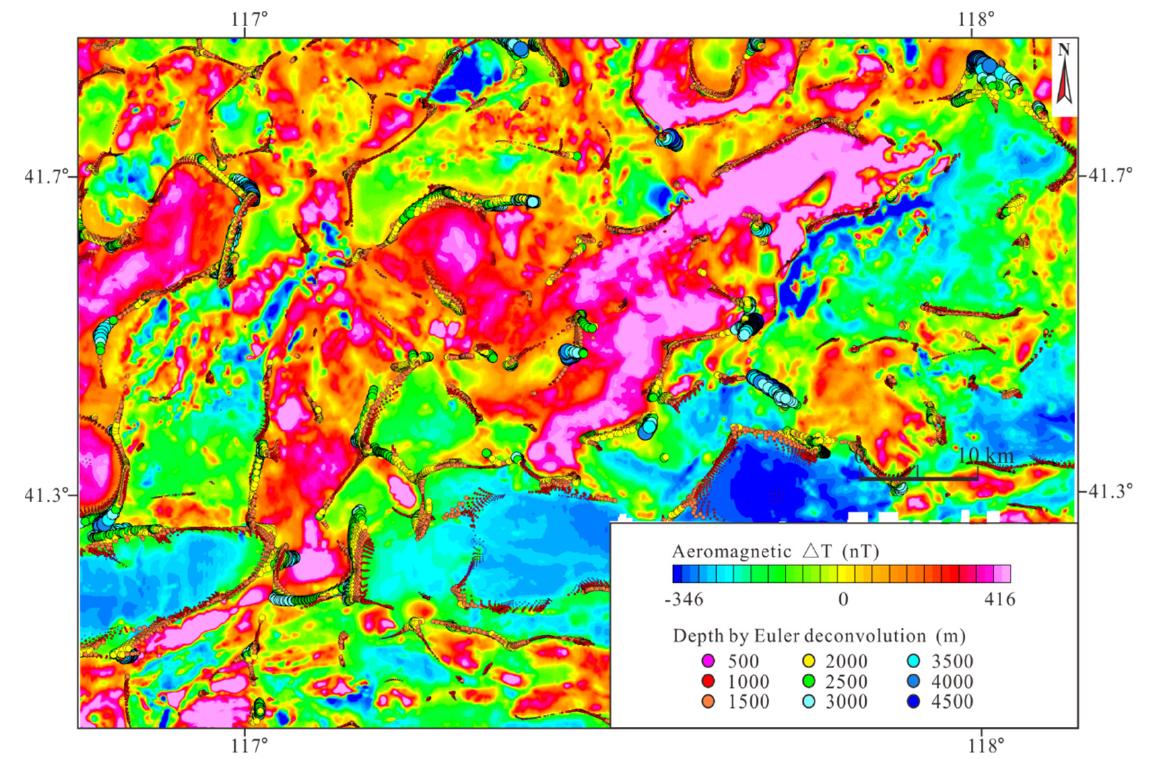
Figure 3. Reduction to the pole of aeromagnetic ∆ T and depth by Euler deconvolution of the study region.